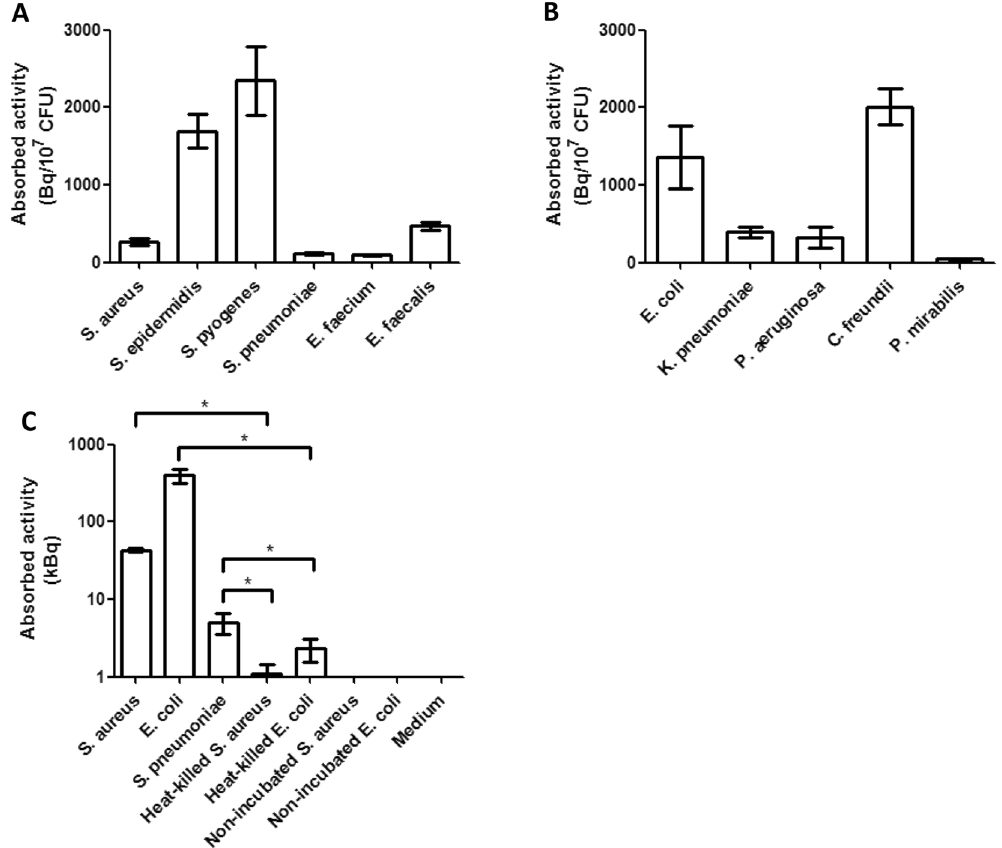
Figure 1. In vitro uptake of 18 F-FDG by different bacteria. The mean uptake of 18 F-FDG by clinical isolates of different Gram-positive ( A ) and Gram-negative ( B ) bacteria was expressed as absorbed activity in Bq/10 7 CFUs. ( C ) Total uptake in kBq of 18 F-FDG by S . aureus , E . coli or S . pneumoniae in comparison to heat-killed bacteria, bacteria not incubated with 18 F-FDG, and medium controls. The indicated standard deviations include the variations introduced by the use of at least two different isolates per tested species. Note that the detection limit for a bacterial species will lie between the nonspecifically absorbed activity measured for heat-killed bacteria, such as E . coli and S . aureus , and the lowest level of 18 F-FDG uptake by the living bacteria, such as S . pneumoniae . This implies that under the tested conditions, the detection limit is ~2.4 kBq. * p ≤ 0.01. Values represent mean ± SEM (n =